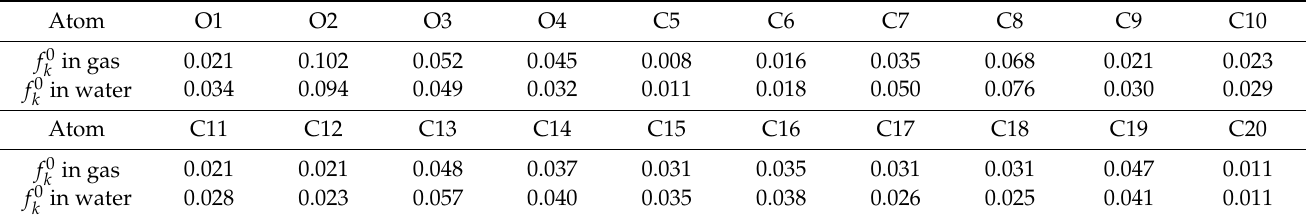
Table 2. The Fukui indices f 0 Figure